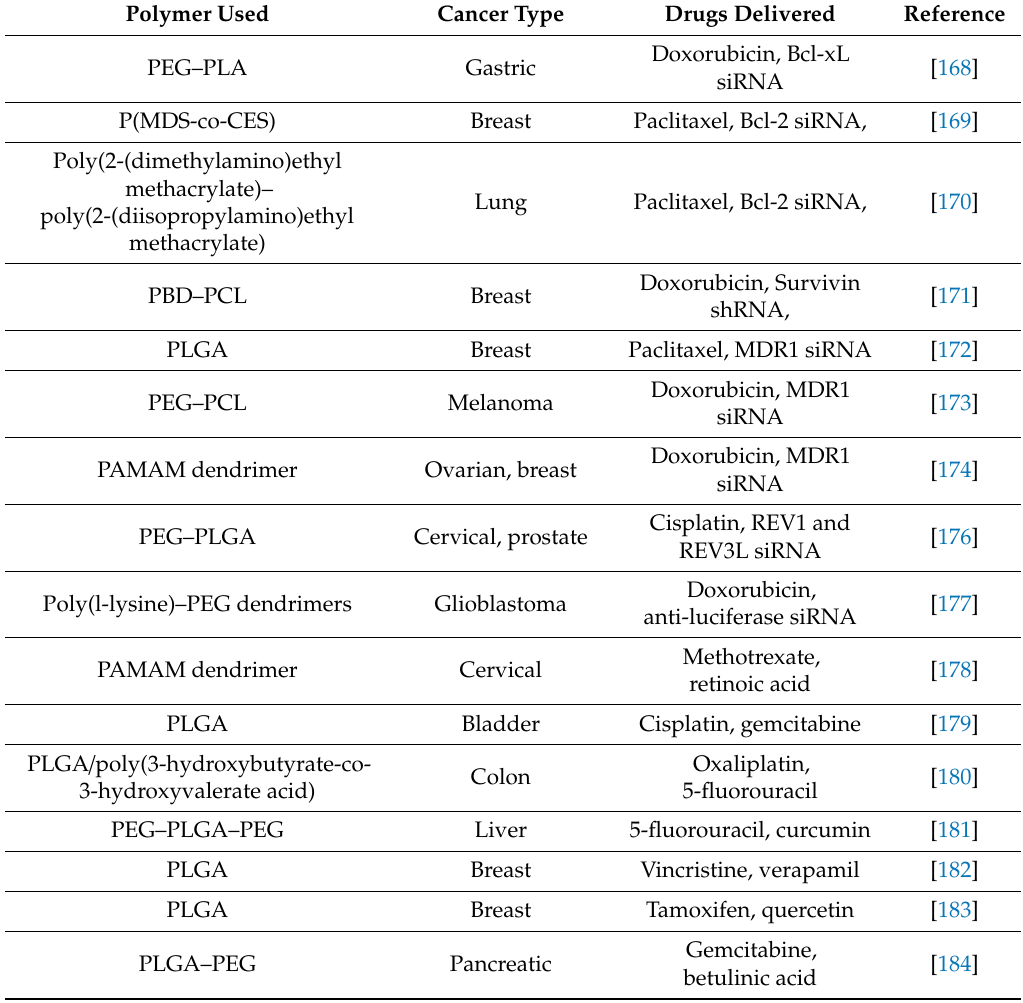
Table 3. Summary of studies using polymeric nanoparticle systems to deliver other combination